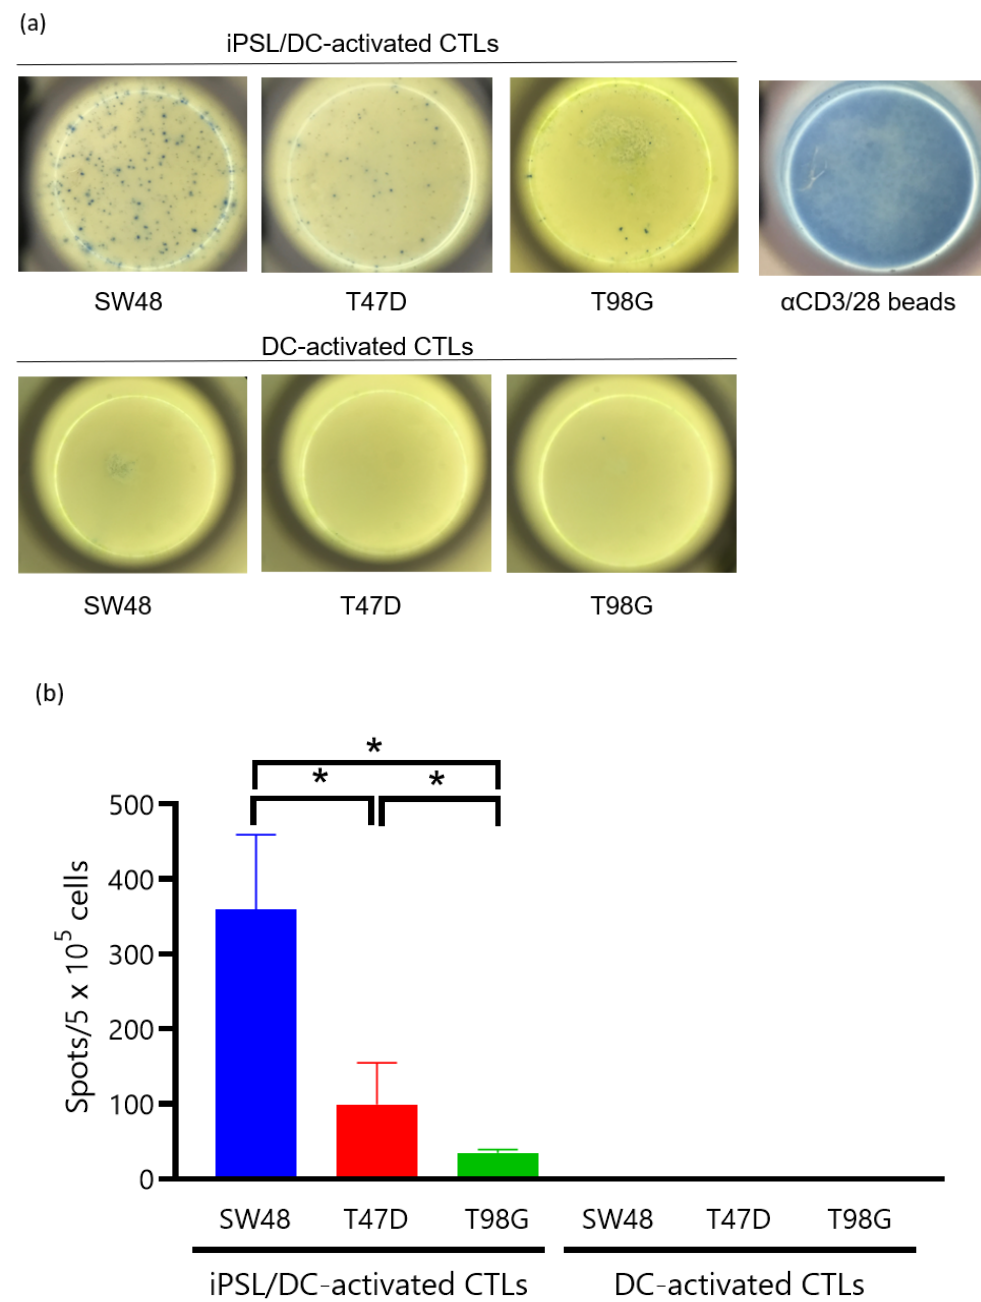
Figure 8. CTLs induced by iPSL/DCs respond to cancer cells carrying HLA-A33. ( a ) Representative photos of IFN γ -based ELISPOT assays. Top row depicts IFN γ -producing spots of iPSL/DC-induced CTLs co-cultured with cancer cells. Rightmost photo depicts the positive control of IFN γ -producing cells stimulated by anti-CD3 and anti-CD28 antibody. Bottom row depicts DC-induced CTLs. ( b ) The graph depicts the frequency of IFN γ -producing cells in 5 × 10 5 CTLs. Data are the mean ± SD of 3–4 experiments with at least > 2 independent experiments. The significance of differences was determined by the Mann–Whitney U test. * p < 0.05.